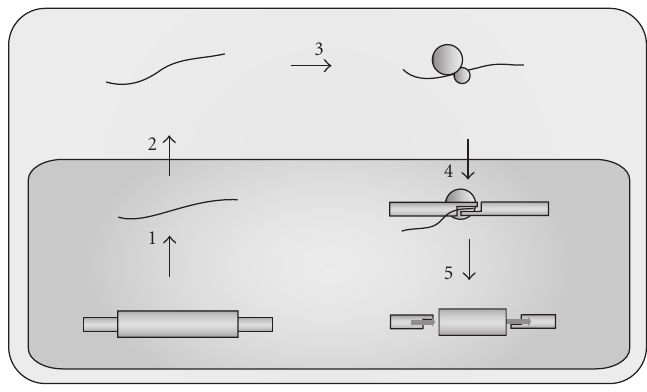
Figure 1: DNA damage can a ff ect multiple stages of the L1 life cycle. (1) Transcription of the L1 element is controlled by epigenetic factors and transcription factors. (2) L1 RNA is exported to the cytoplasm, where its copy number influences retrotransposition frequency. (3) Translation of ORF1 and ORF2 proteins. (4) L1 protein and mRNA are imported into the nucleus, where ORF2 endonuclease creates a DNA double-strand break. Induced breaks may be able to serve as alternative substrates for insertion. (5) ORF2 reverse transcribes a cDNA copy of L1 at the insertion site. Host factors are thought to inhibit or assist in resolution of the insertion. The dark square represents the cell nucleus, and the lighter surrounding square represents the